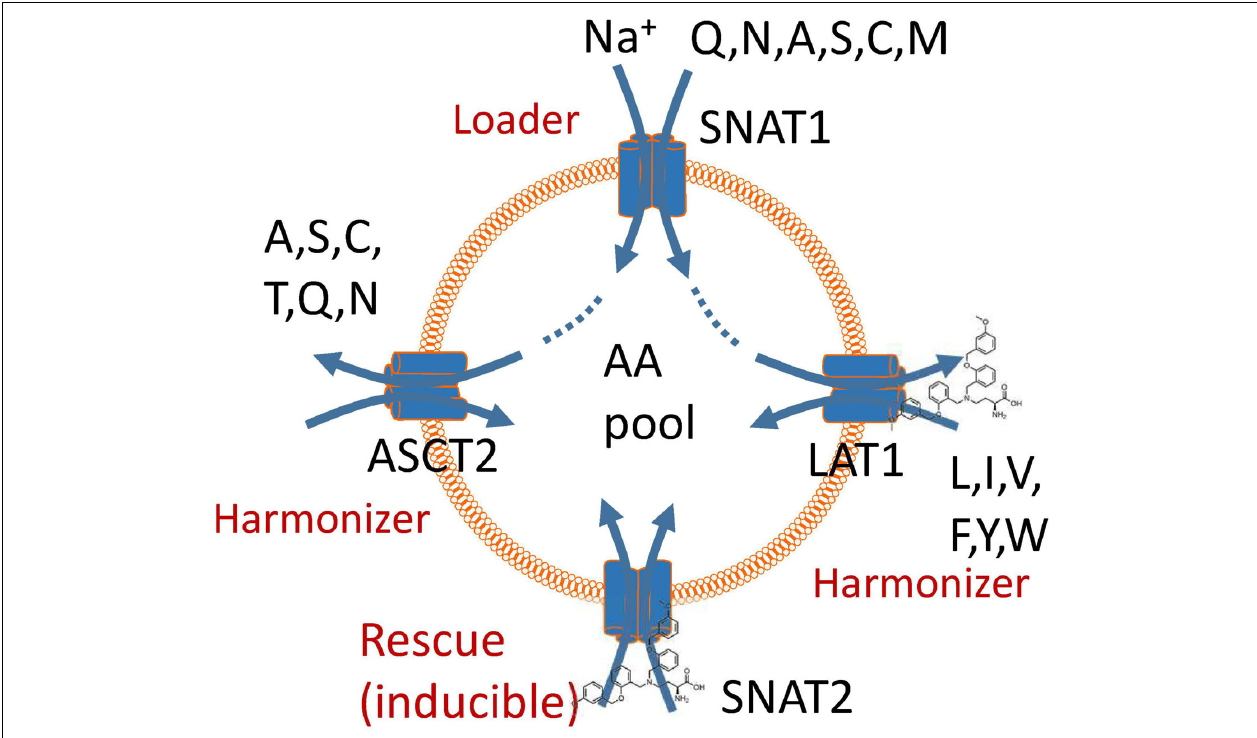
FIGURE 5 | A model of amino acid homeostasis in cancer cells. The physiological role of SNAT1 is to accumulate non-essential amino acids in the cytosol (loader). These are used as exchange substrates to bring the remaining neutral amino acids into the cytosol via exchangers ASCT2 and LAT1, thus harmonizing amino acid pools. Blockade of LAT1 causes a rescue response resulting in the induction of SNAT2. Block of these two transporters impairs accumulation and harmonization of amino acid pools in cancer cells and also negates the rescue